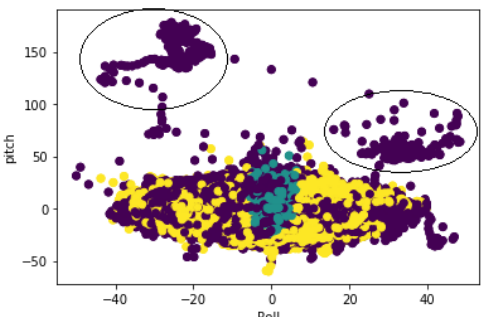
Figure 2. Pitch vs. roll in flight trajectory clusters obtained from GMM.